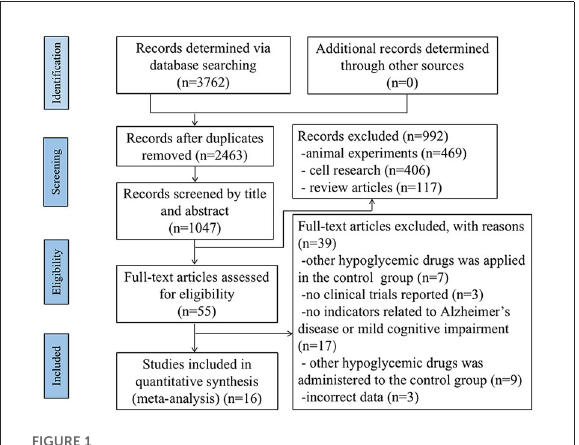
FIGURE1 PRISMA flow diagram for search and selection of eligible studies included in the network meta-analysis.